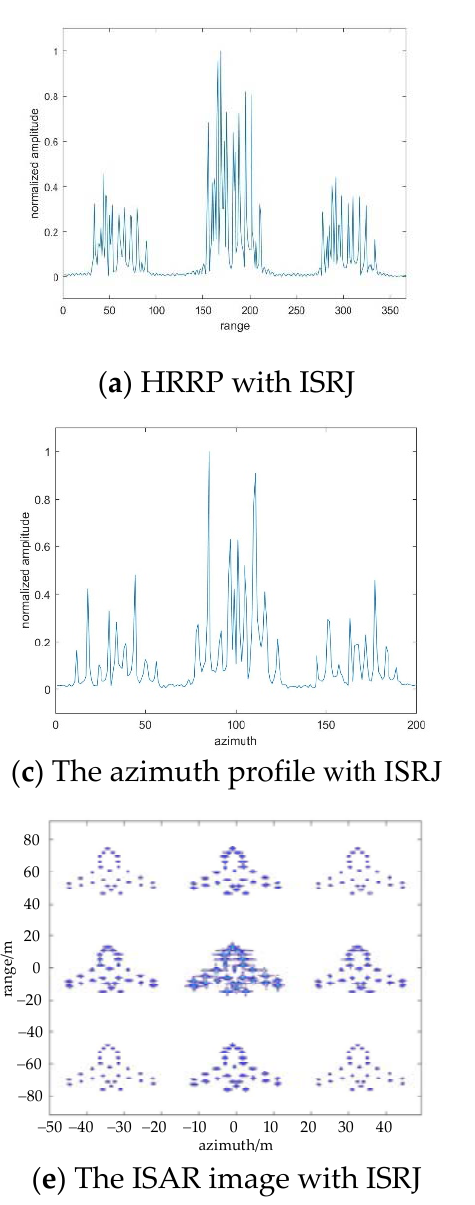
Figure 8. The results of ISRJ jamming and anti-jamming in the fast time domain, slow time domain, and ISAR image with JSR = dB 20 .